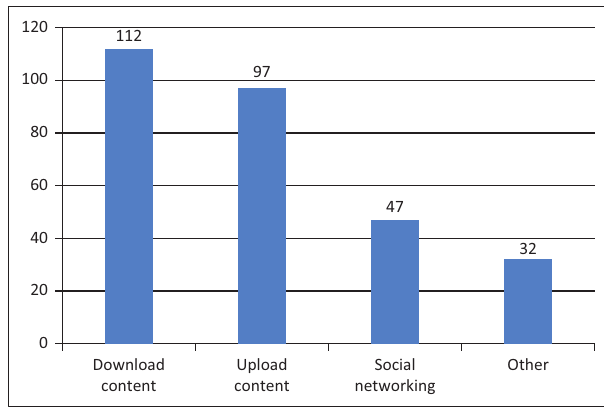
FIGURE 10: Utilisation of the church online presence.